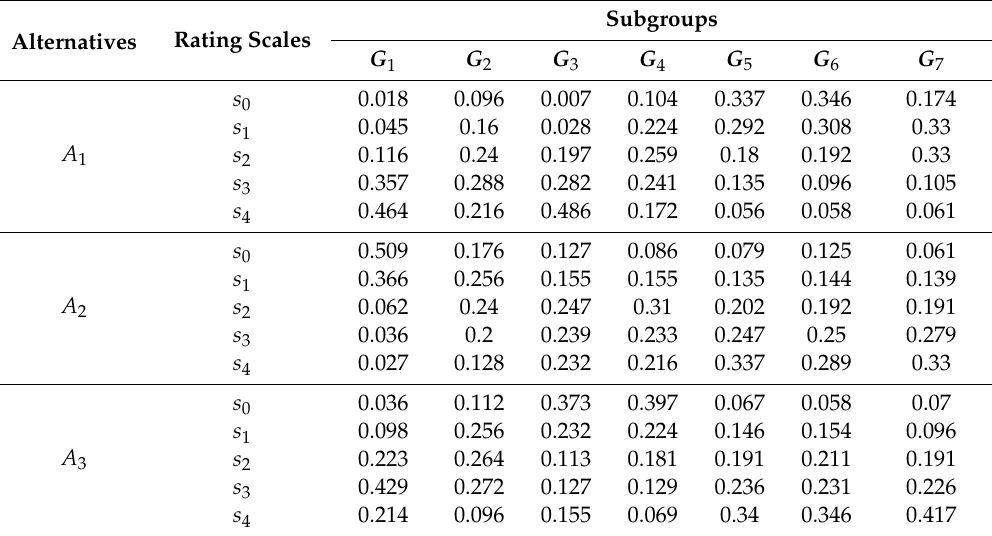
Table 7. The distribution evaluations of the alternatives.